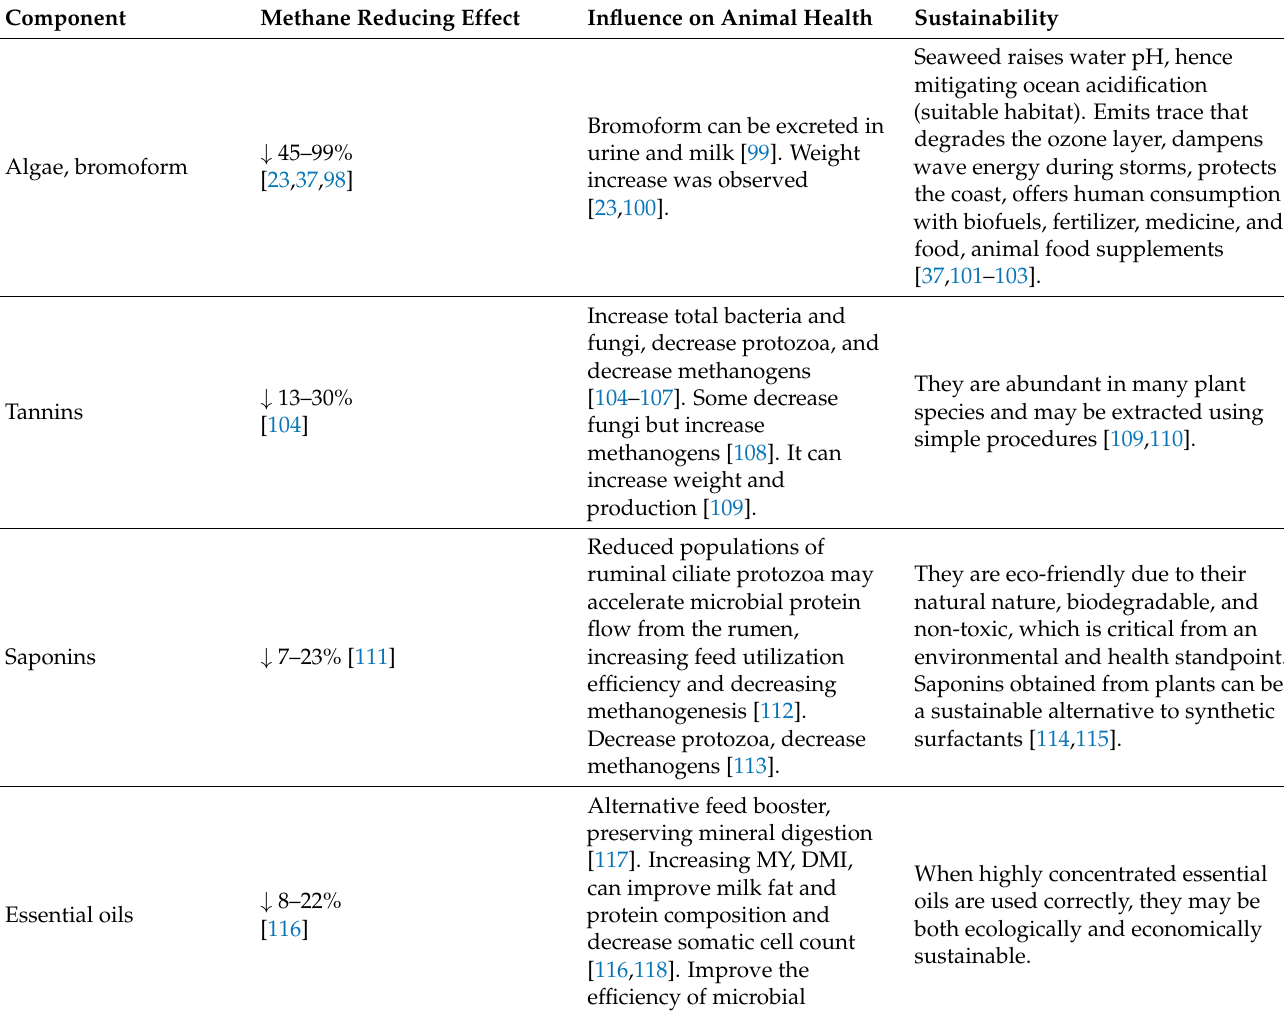
Table 3. Some of the methane-reducing supplements, their impact on animal health and